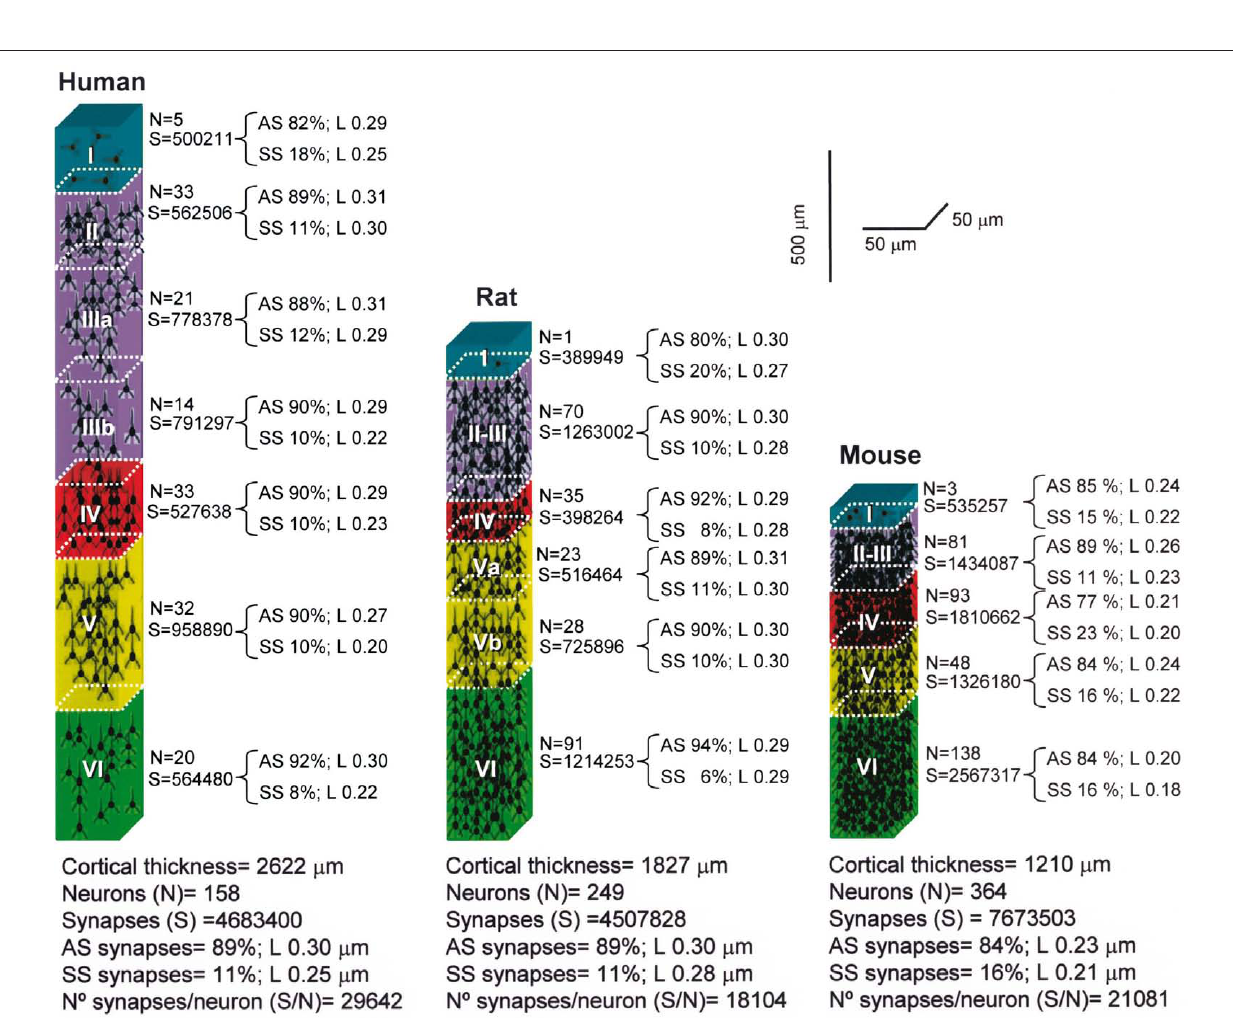
temporal cortex; T2–T3), rat (hindlimb area of the somatosensory cortex), and mouse (barrel cortex). L, cross-sectional length of synaptic junctions; AS, asymmetric synapses; SS, symmetric synapses. Values taken from DeFelipe et